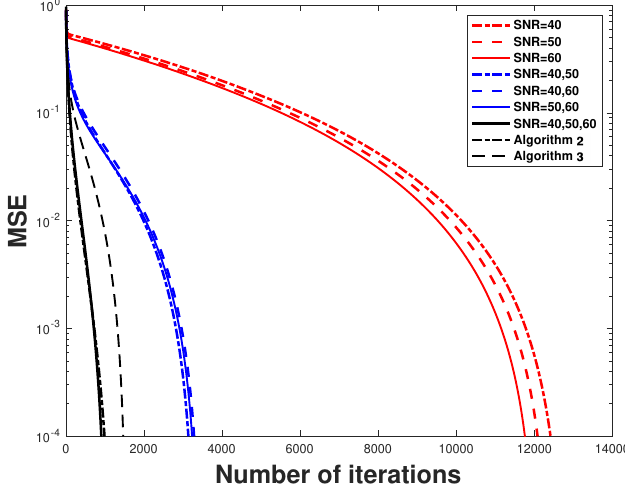
Figure 15. MSE versus number of iterations in case N = 1024 and M =